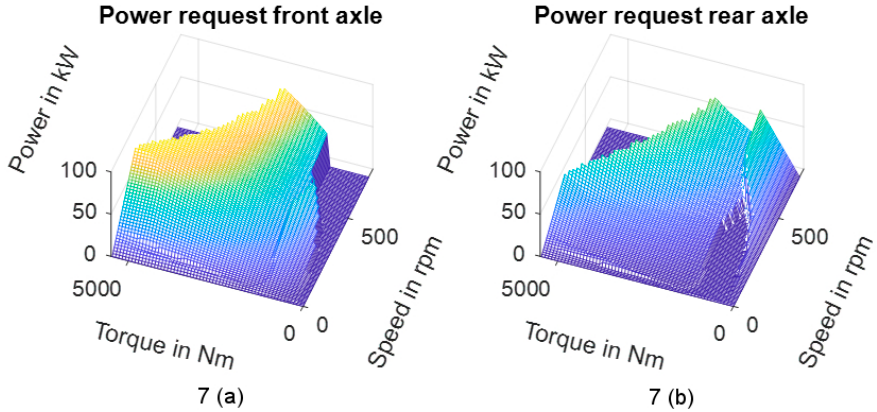
Figure 7. Example of the motor power distribution between two 100 kW motors in first gear 7 ( a ) Power request at front axle; 7 ( b ) Power request at rear axle.